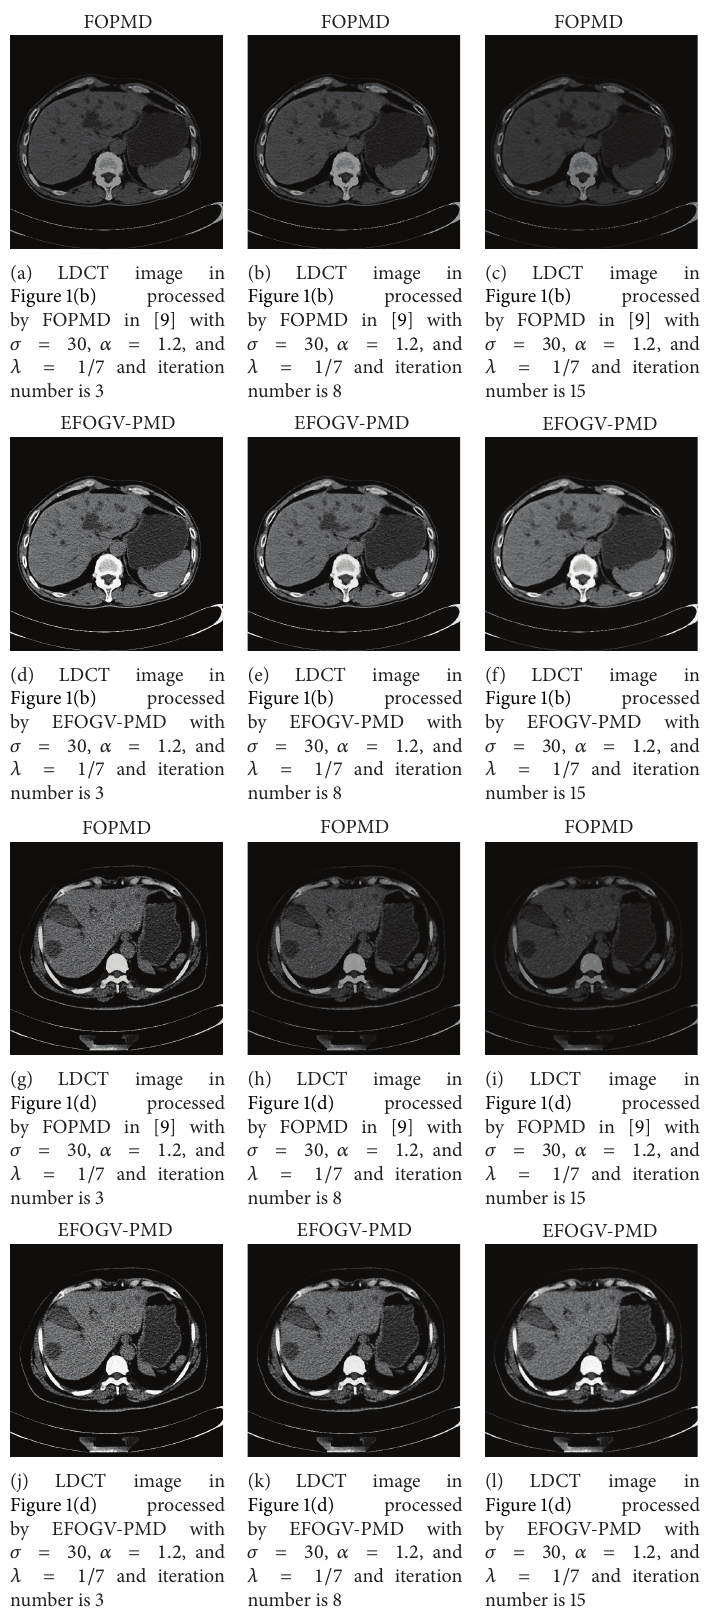
Figure 3: LDCT images in Figures 1(b) and 1(d) processed by FOPMD and EFOGV-PMD with different iteration numbers and the fractional- order 𝛼 = 1.2 . The first column: iteration number is 3; the second column: iteration number is 8 and the third column: iteration number is 15. The first row: Figure 1(b) processed by FOPMD; the second row: Figure 1(b) processed by EFOGV-PMD; the third row: Figure 1(d) processed by FOPMD and the fourth row: Figure 1(d) processed by